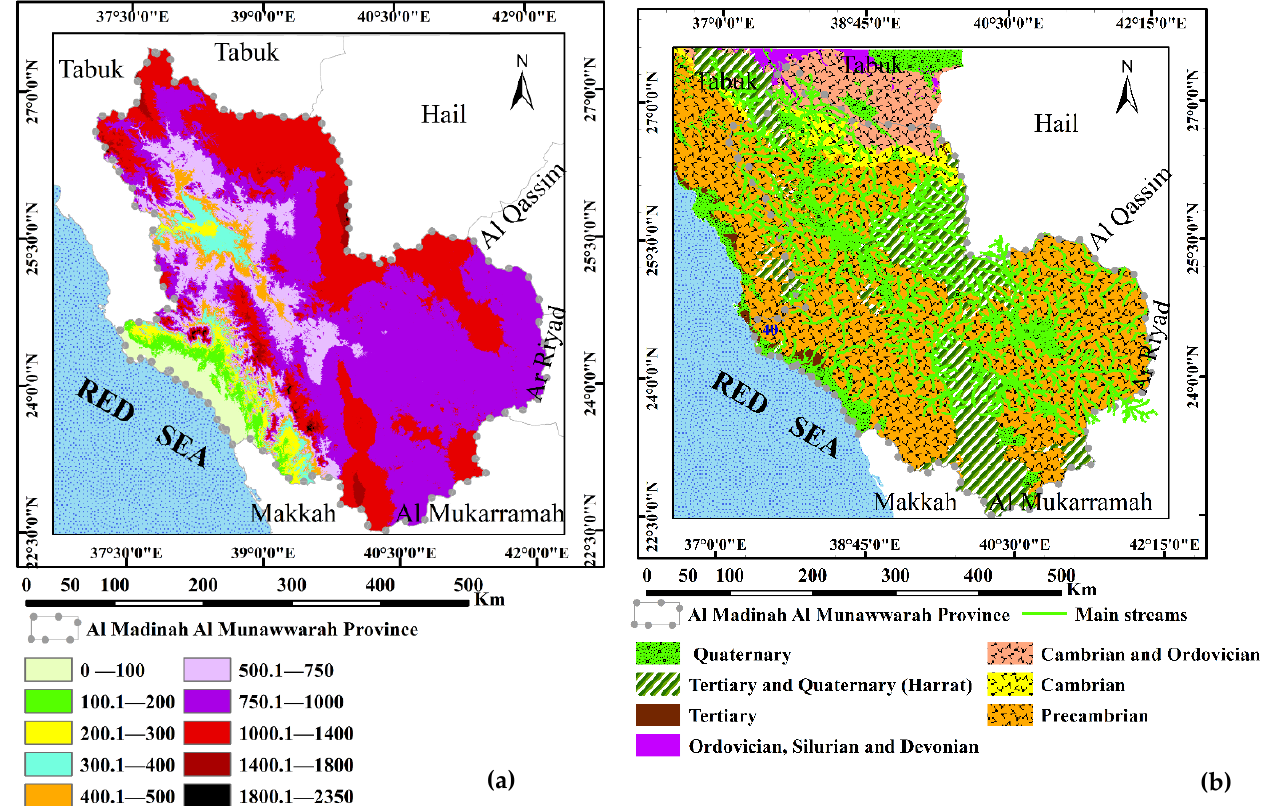
Figure 4. Digital elevation model (DEM) ( a ) and geological map ( b ) of Al Madinah Al Munawarah Province.